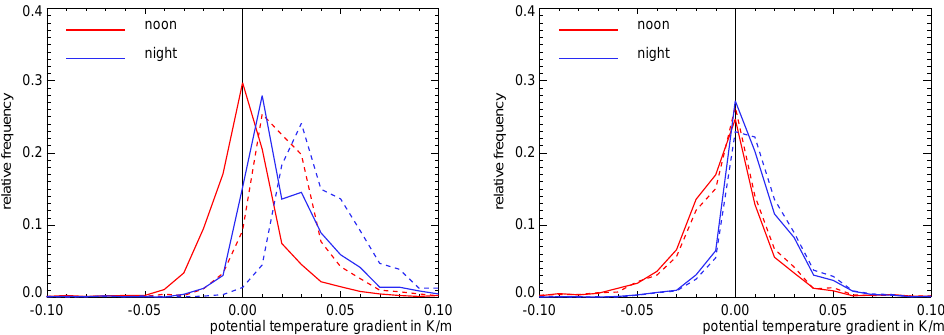
∆ T/δh Figure6:Frequen ydistributionofquotient atlowestheightinterval(60m-40m,left)andatelevated Fig. 6. Frequency distribution of quotient 1T / δh at lowest height interval (60m–40m, left) and at elevated height interval (140m–120m, heightinterval(140m-120m,right)aroundnoonandmidnightforMuni h.Dashedlines:un orre tedtemperature, right) around noon and midnight for Munich. Dashed lines: uncorrected temperature, solid lines: corrected temperature. Figure7:Temperaturepro(cid:28)lesatMuni hairportwithout(bla k)andwith(red)empiri aladiabati orre tions solidlines: orre tedtemperature.